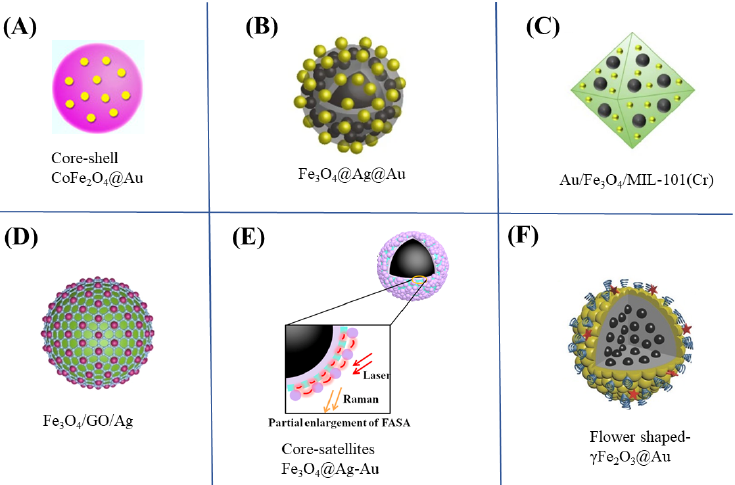
Figure 3. Typical MNP-based SERS substrates with different shapes: ( A ) sphere-like core–shell Fe 3 O 4 @Au. Reproduced with permission from Ref. [46]. Copyright 2016, American Chemical